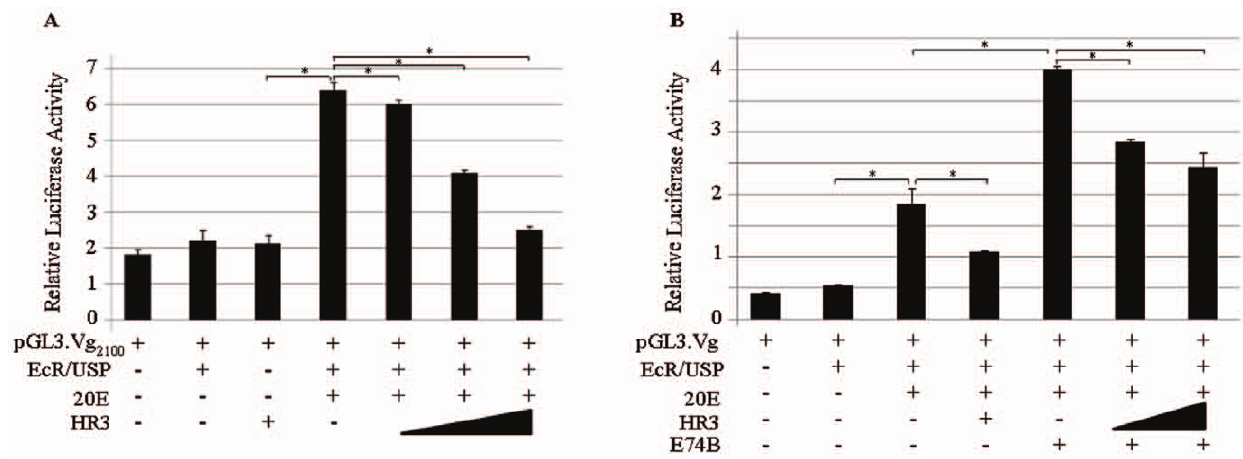
Figure 2. HR3 inhibits 20E-dependent activation of the A.aegypti Vg gene promoter in luciferase reporter assays. (A) Drosophila KC- L57-3-11 cells were transiently transfected with 300 ng of the reporter construct pGL3.Vg 2100 (carrying 2.1 Kb of the A. aegypti Vg promoter) and the expression plasmids pAc5.EcR (0.2 microg) and pAc5.USP (0.2 microg), indicated as EcR/USP. The expression plasmid pAc5.HR3 (HR3) was added at 0.2, 1 or 2 microg. Expression assays were conducted in the presence ( + ) or absence ( 2 ) of 1 m M 20E for 36 h. 50 ng of the control expression vector pRLCMV. Renilla luciferase was co-transfected for normalization. (B) The assay was conducted in a similar manner, but with the addition of 0.2 m g of the expression plasmid pAc5.E74B (E74B). The expression plasmid pAc5.HR3 was added at 1 or 2 microg. Relative luciferase activity represents ratios of firefly luciferase to Renilla luciferase readings. Values are the mean of three replicates ( 6 SEM). The experiment was repeated three times. *Indicates statistical significance , 0.05.